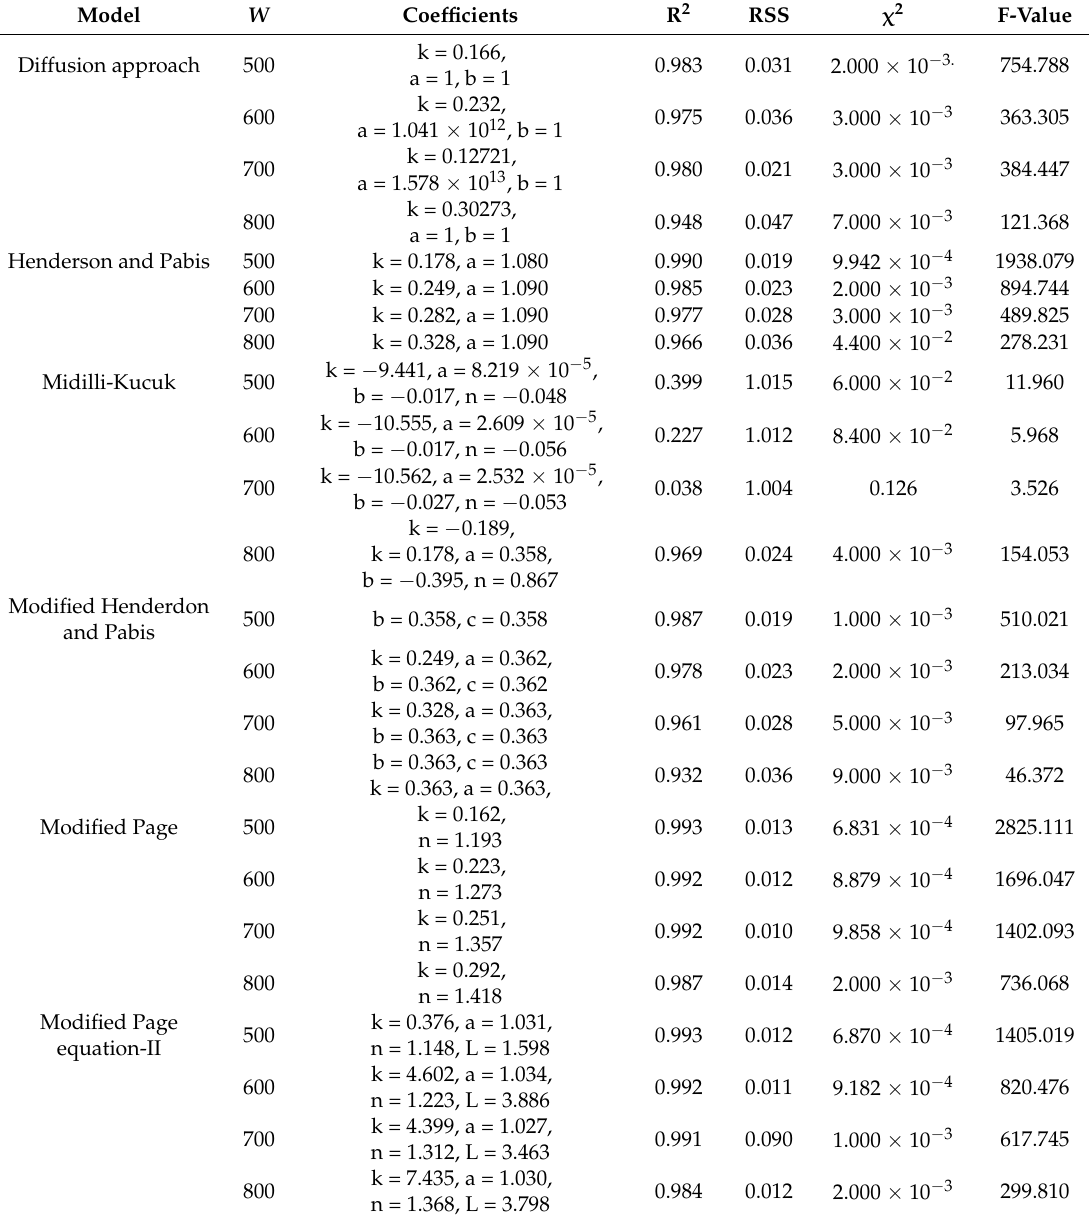
Table 4. Evaluated results of mathematical thin-layer drying models at different microwave power